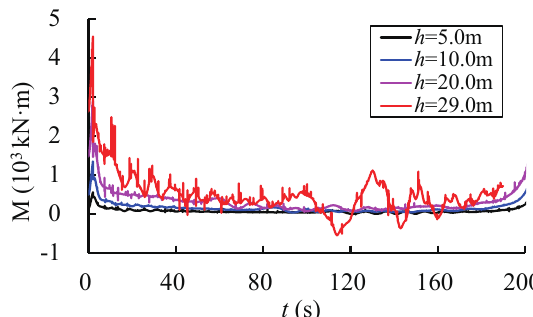
Figure 13. The hydrodynamic resistance moment at different initial submerged depths.